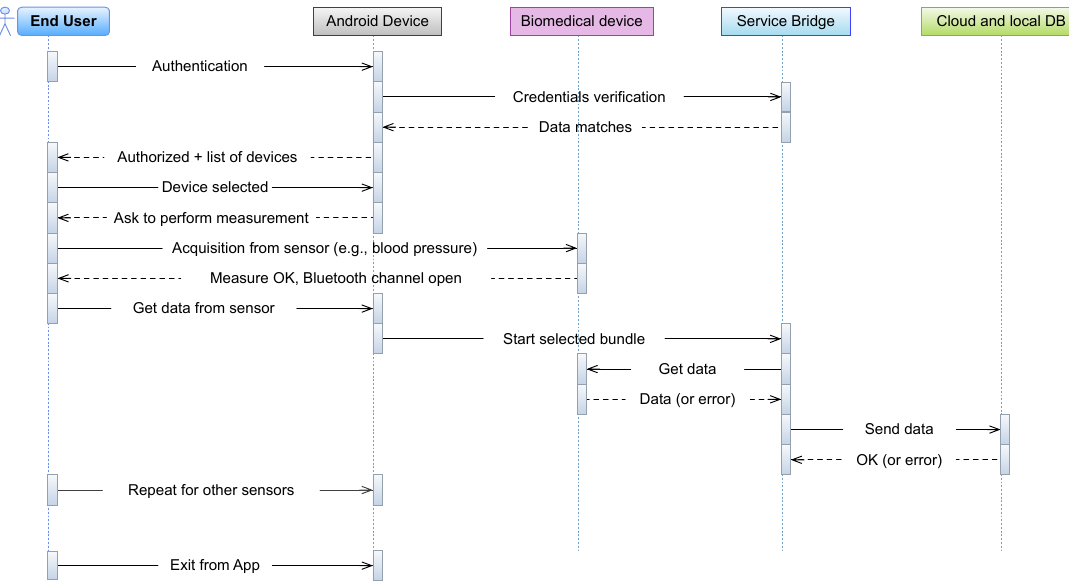
Figure 7. Overview of how the user interacts with the Health App and performs a